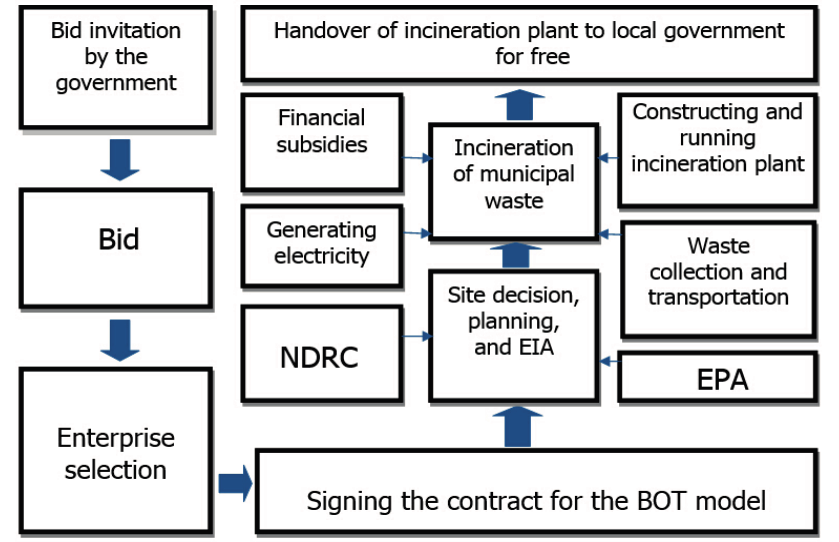
Figure 1. The waste incineration project based on the BOT